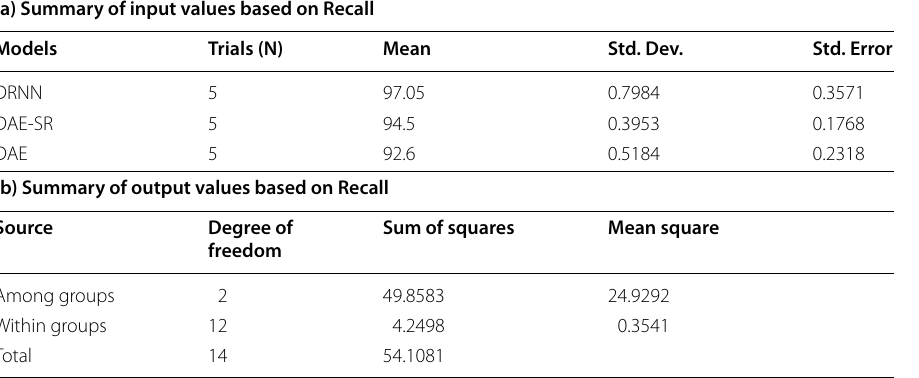
Table 12 Summary of input/output values based on Recall (a) Summary of input values based on Recall Models Trials (N)